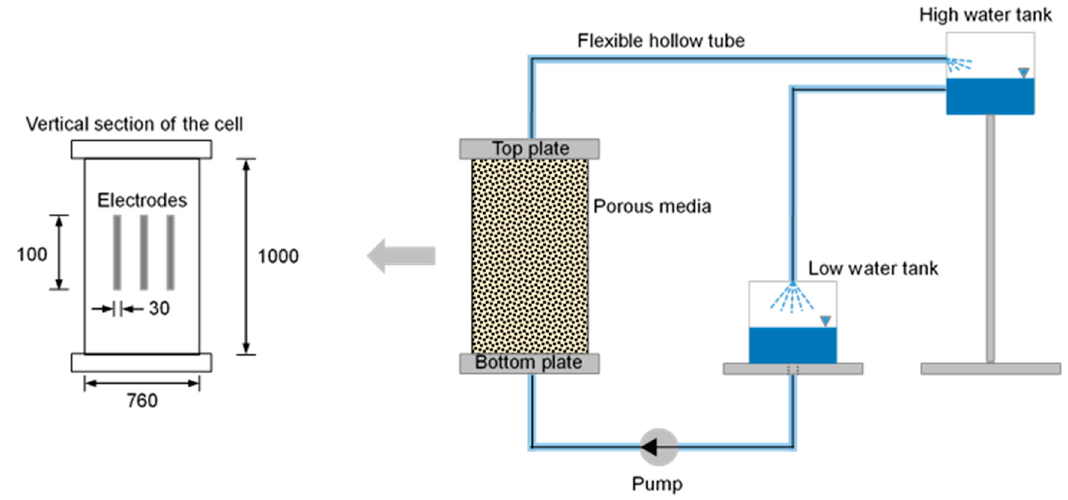
Figure 3. Test configuration for measuring the dielectric constant with various saturation conditions. The water is continuously circulated when the dielectric constant shows the fully saturated value. The dimension unit is mm.